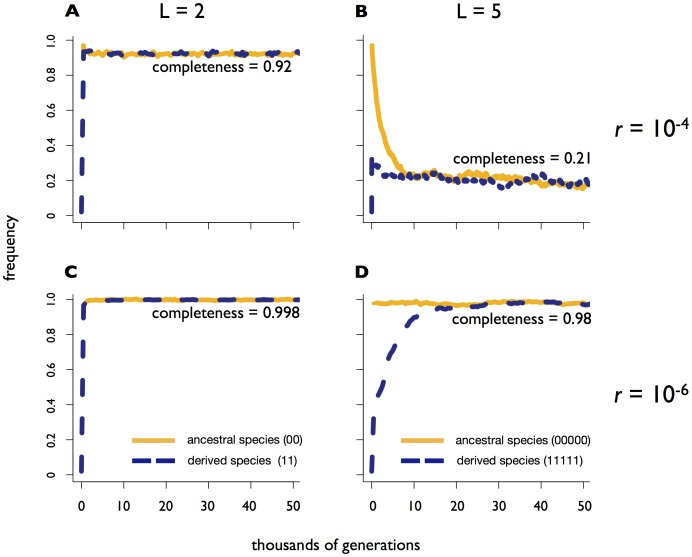
Higher recombination rates maintain intermediate genotypes and reduce the completeness of speciation.Panels A, B, C and D show dynamics of a single simulation under different combinations of L (number of adaptive loci) and r (recombination rate), corresponding to magenta letters in Figure 2C. The y-axis shows the frequency of optimal genotypes in a given niche (ancestral or derived).